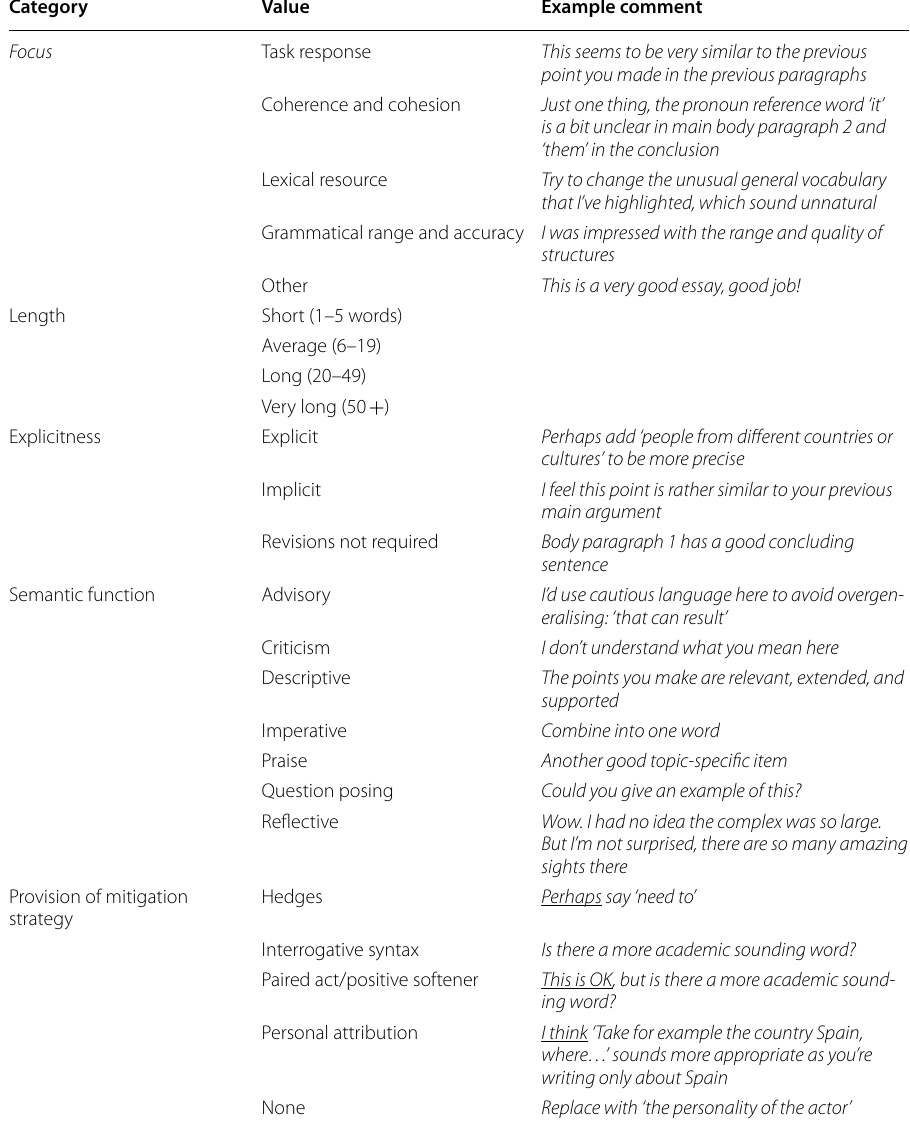
Table 1 Analytic model for written commentary Category